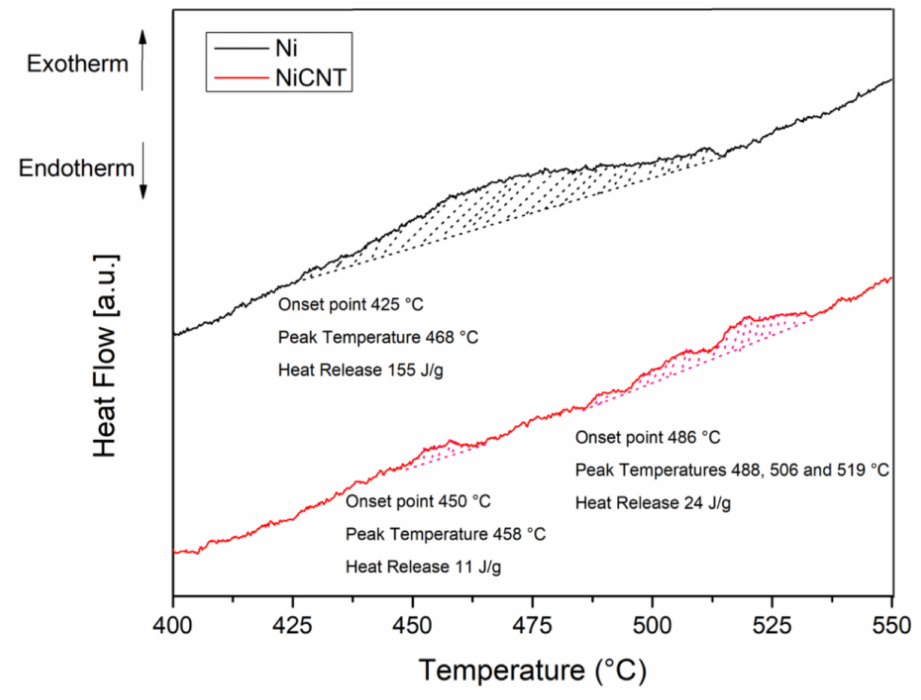
Figure 14. DSC curves of Ni and Ni-CNT produced with 300 min of ball